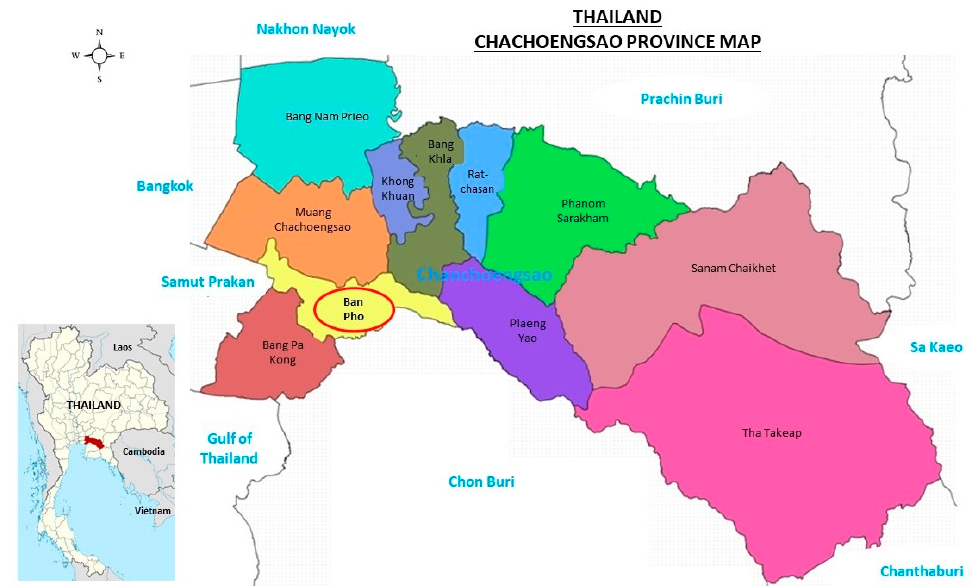
Figure 2. Map showing Chachoengsao (CCS) province including the districts of Ban Pho for context (source: modified from https: // en.wikipedia.org / wiki / Chachoengsao_Province and https: // dmcrth.dmcr. go.th / mcra2 / aboutus / 444 /